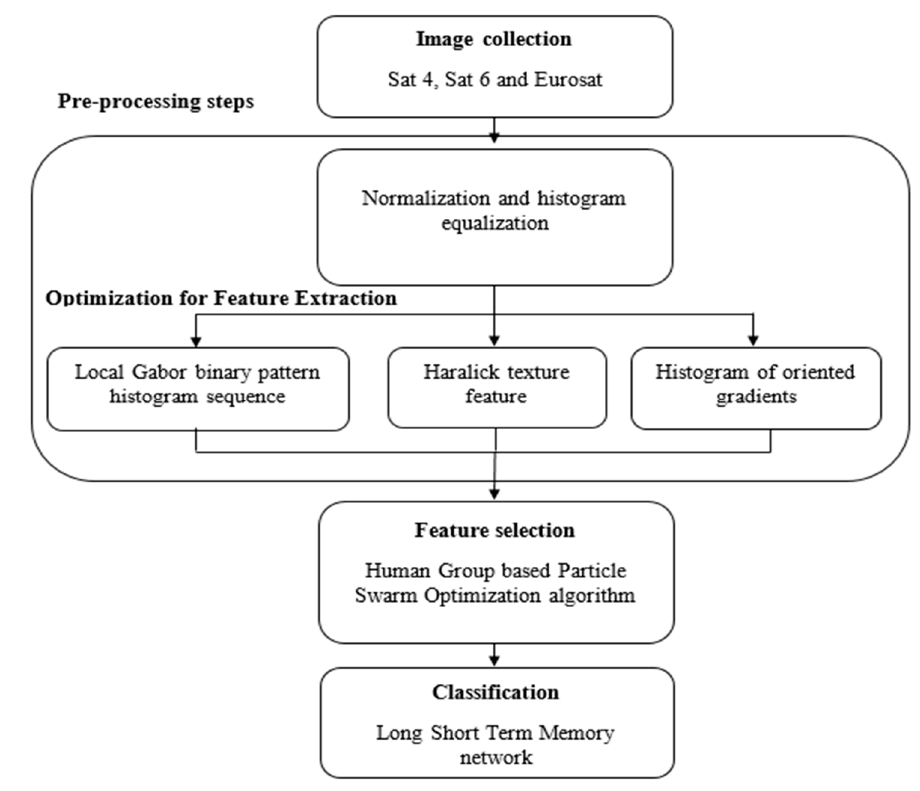
Figure 1. Work flow of the complete human group-based particle swarm optimization (PSO) with long short-term memory (LSTM), highlighting the main macro steps.